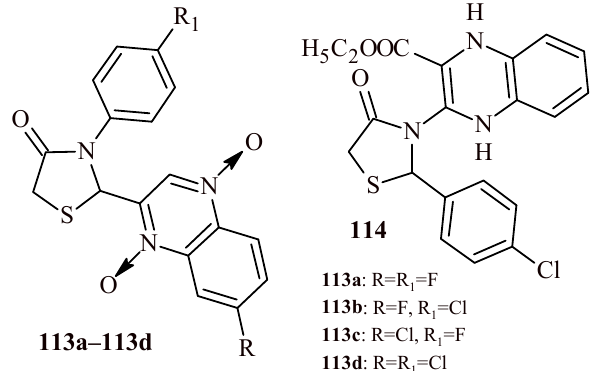
Figure 48. The structures of thiazolidin-4-ones with benzothiazole and benzimidazole moieties. Zhang et al. reported antifungal activity of Compounds 113a – 113d against C. albicans , Candida tropicalis , Aspergillus fumigatus and C. neoformans fungal strains with MIC in the range of 2–4 µg/mL [120]. Other derivative with quinoxaline moiety ( 114 ) showed com- parable antibacterial and antifungal activity to reference drugs ampicillin (inhibition zone 23–28 mm) and amphotericin B (inhibition zone 14–20 mm) (Figure 49). The inhibition zone of 114 against S. aureus and E. coli were 24 and 19 mm, respectively. The Compound 114 inhibited growth of A. flavus and C. albicans with inhibition zone 13 mm [121]. The Compounds 11 and 43a (Figure 7 and Figure 18) exhibited strong antimicrobial activity against four bacterial ( E. coli , K. pneumoniae , S. aureus and B. subtilis ) and three fungal ( A. niger , Aspergillus oryzae and C. albicans ) strains with MIC = 1.5 µg/mL. This ac- tivity was comparable or slightly better than reference drugs streptomycin, ciprofloxacin and fluconazole [25,26].